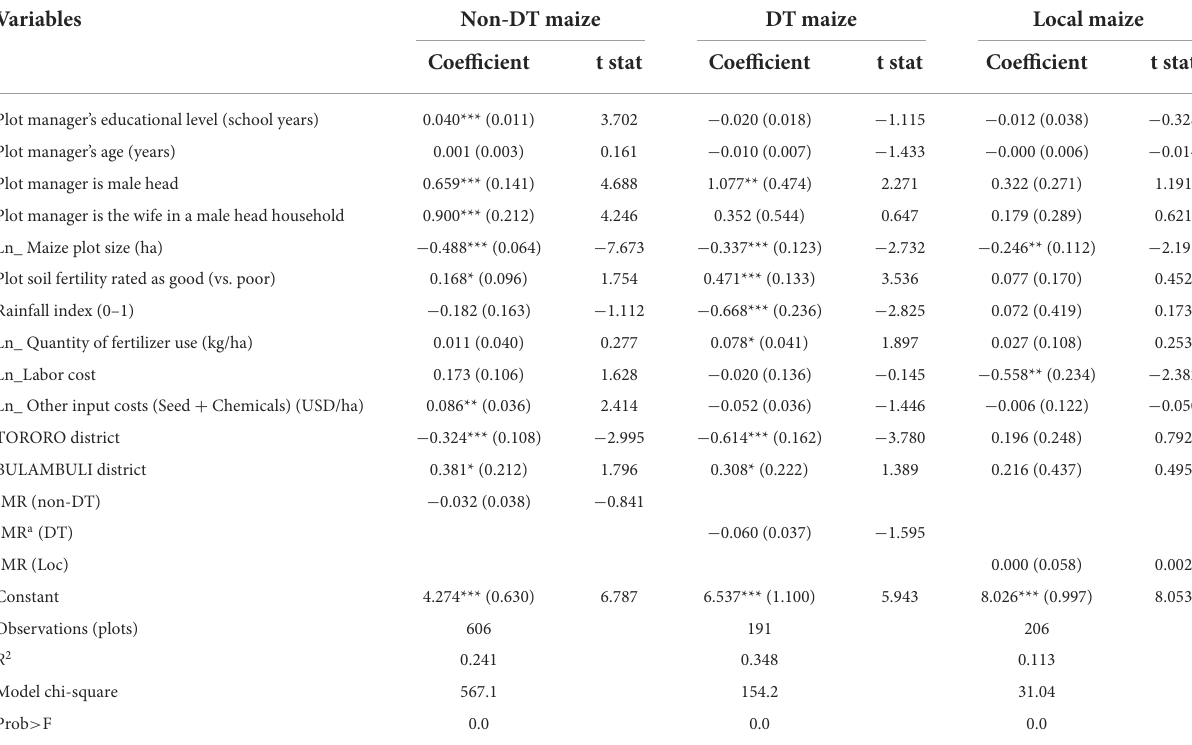
TABLE A2 Endogenous switching regression estimate for outcome indicator-maize yield.